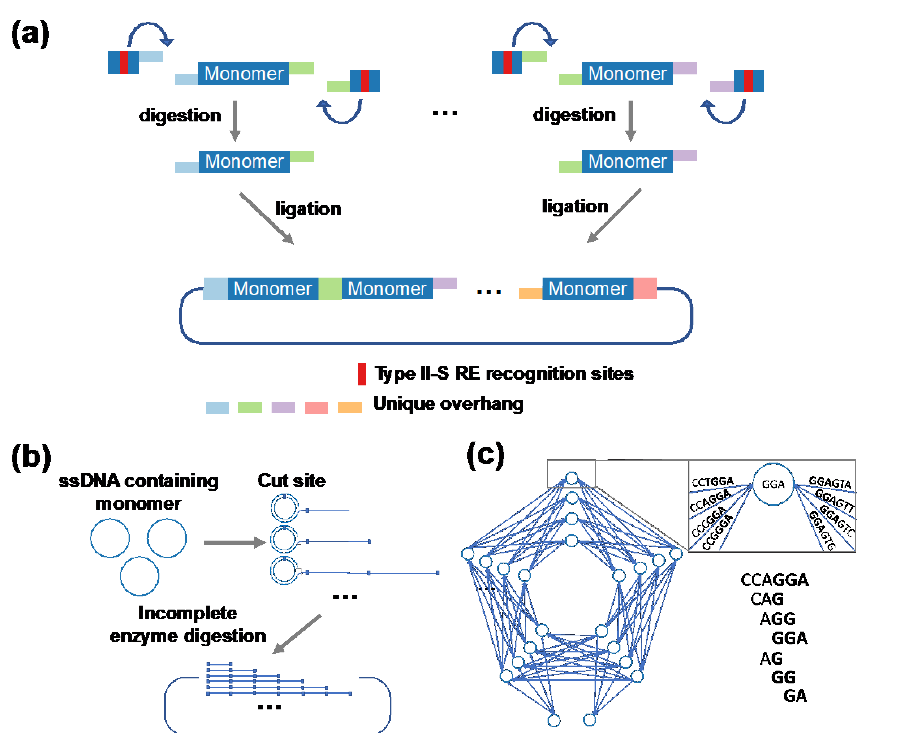
Figure 1. Methods for assembling repetitive DNA to encode repetitive proteins. ( a ) Golden Gate DNA assembly. ( b ) Rolling circle amplification. ( c ) Combinatorial codon scrambling for synthesizing repetitive DNAs [13,18,19] .